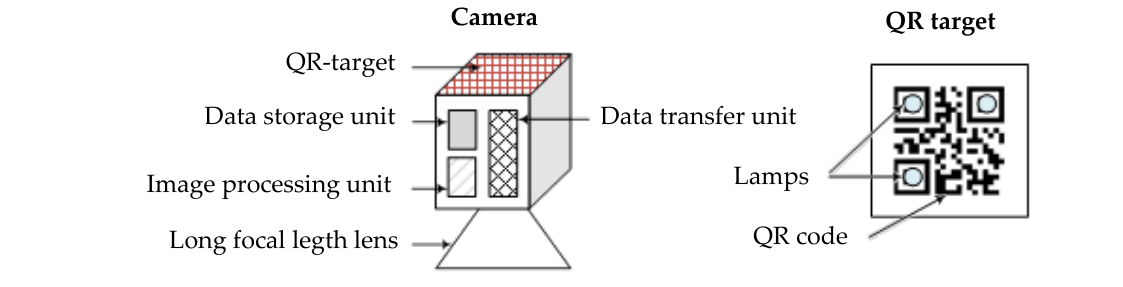
Figure 4. VOS sensor and target.